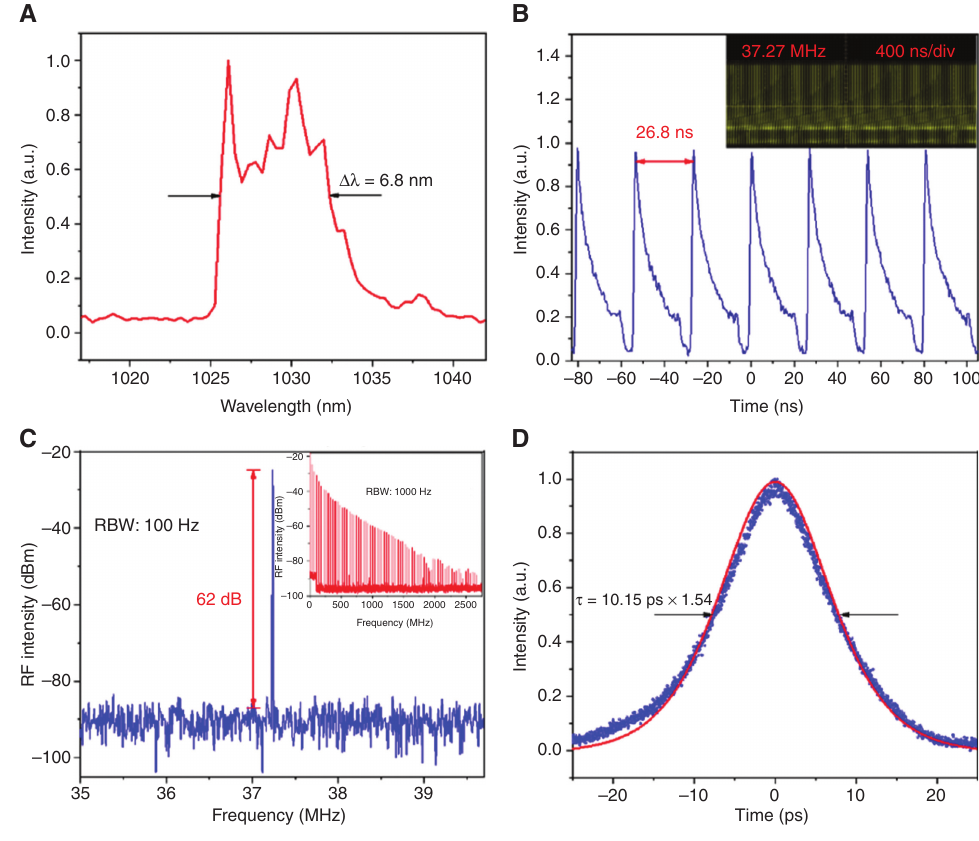
Figure 5: The results of hybrid mode-locking YDFL. (A) Optical spectrum. (B) Pulse trains of mode-locking operation at pump power of 320 mW. Inset: Oscilloscope traces. (C) RF spectra. (D) Autocorrelation trace for the output pulse.